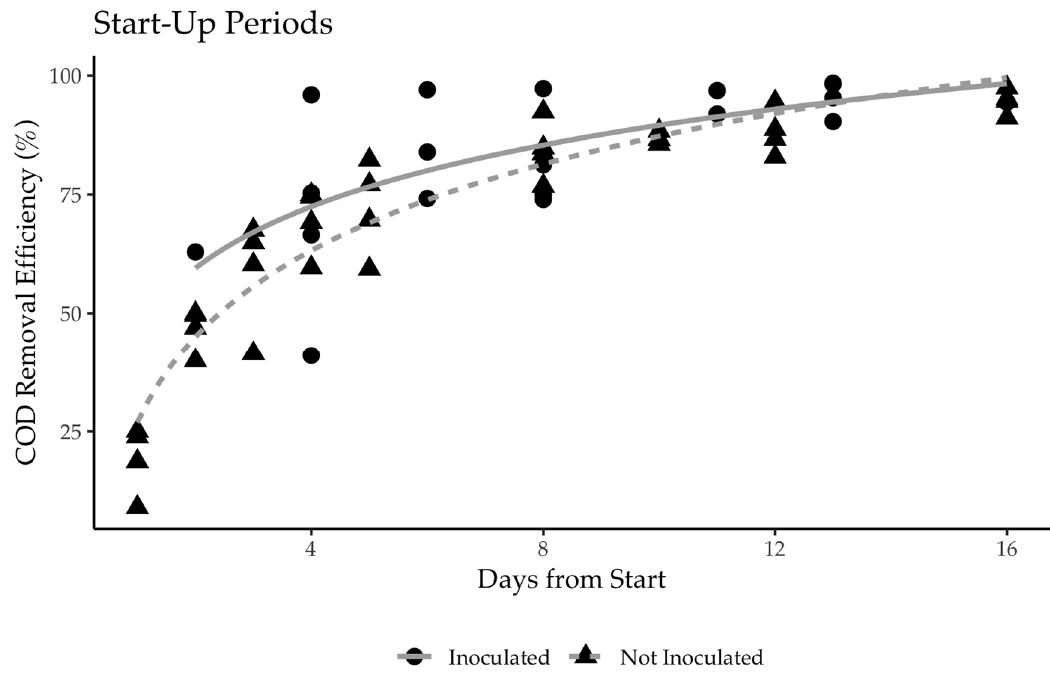
Figure 4. Variation of the chemical oxygen demand (COD) removal efficiency during the start-up period with column inoculated and not inoculated prior to operation.